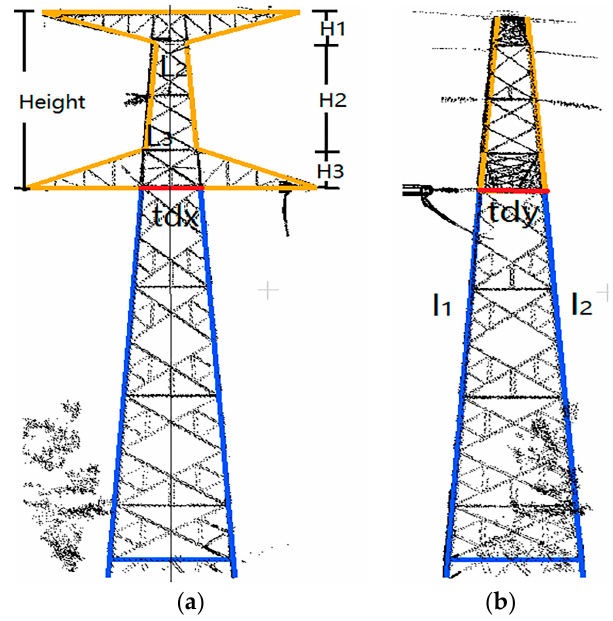
Figure 7. Geometric relations. ( a ) the front view of a pylon; and ( b ) the side view.